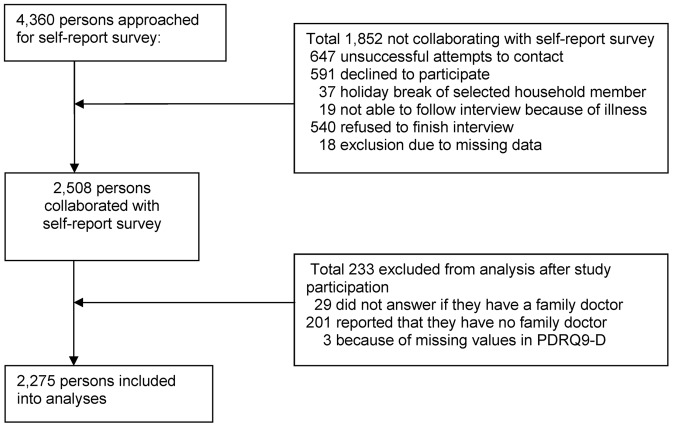
Study flow diagram.